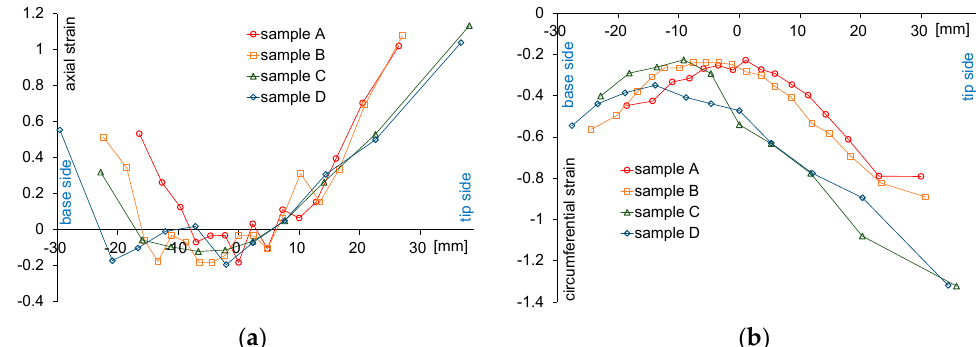
Figure 11. Distributions of ( a ) axial strain and ( b ) circumferential strain in the axial direction of the outer curve. The horizontal axis represents the distance along the curved surface in the axial direction. The origin is at the middle cross section perpendicular to the spindle axis.